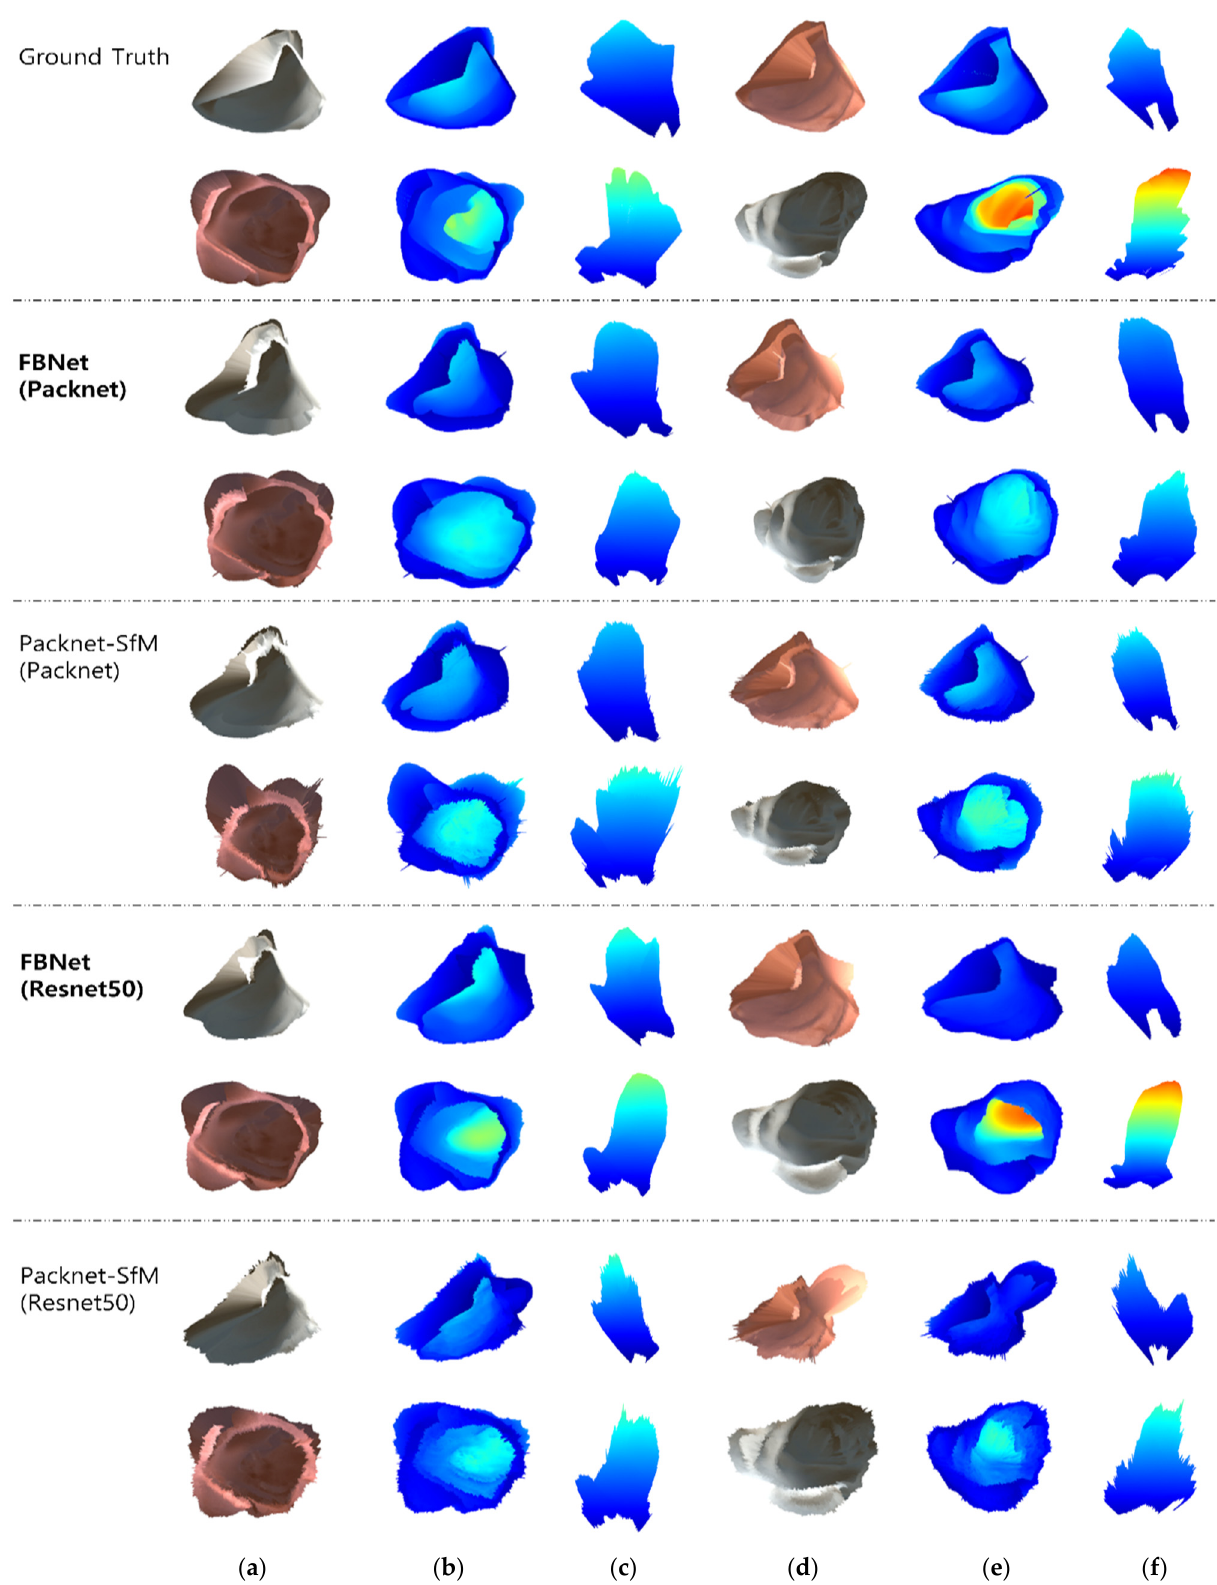
Figure 7. Qualitative results for 3D reconstruction. We compare the results of 3D reconstruction of the images in the first to fourth columns of Figure 6. ( a , d ) are the results of 3D reconstruction image mapping. ( b , e ) are expressed as colormaps according to the depths of ( a , d ). ( c , f ) are the top-view of ( b , e ).